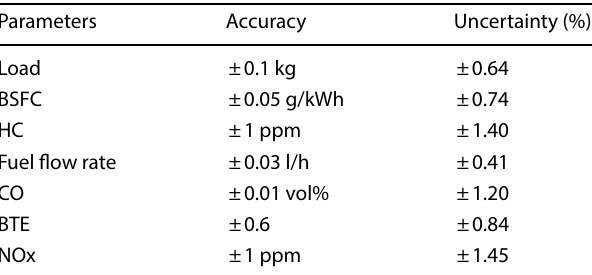
Table 5 Test result summary of uncertainty and experimental accu- racy Parameters